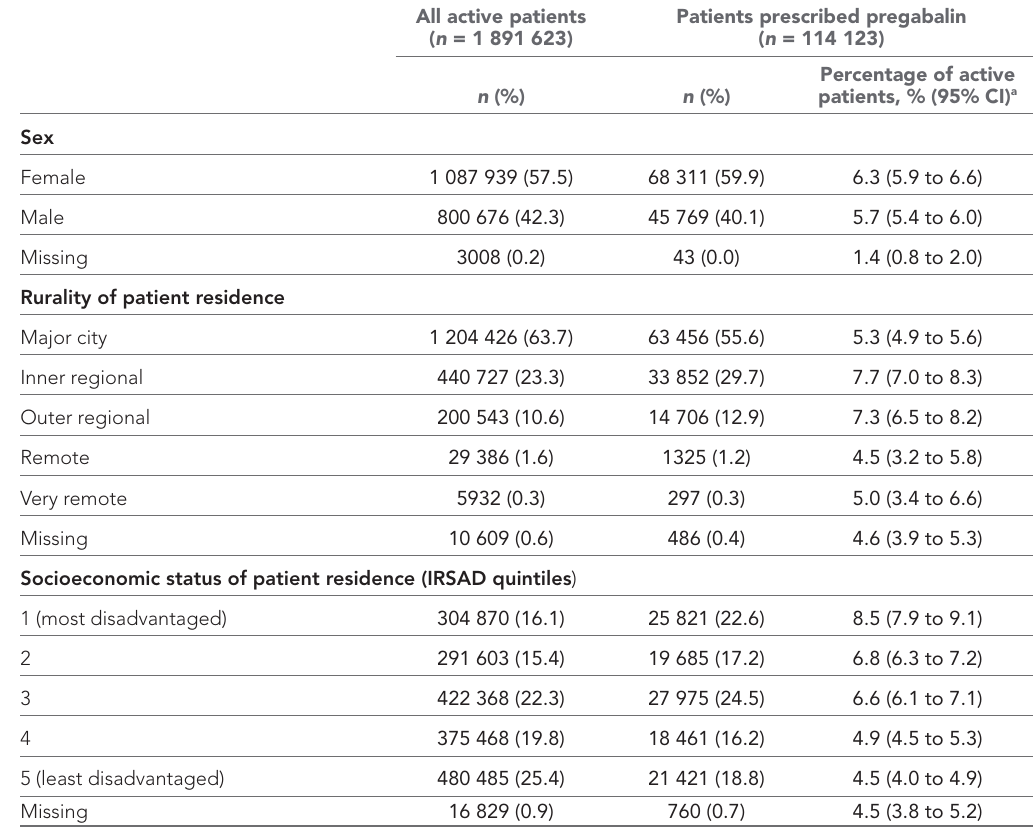
Table 1 Characteristics of the full study cohort and people prescribed pregabalin, March